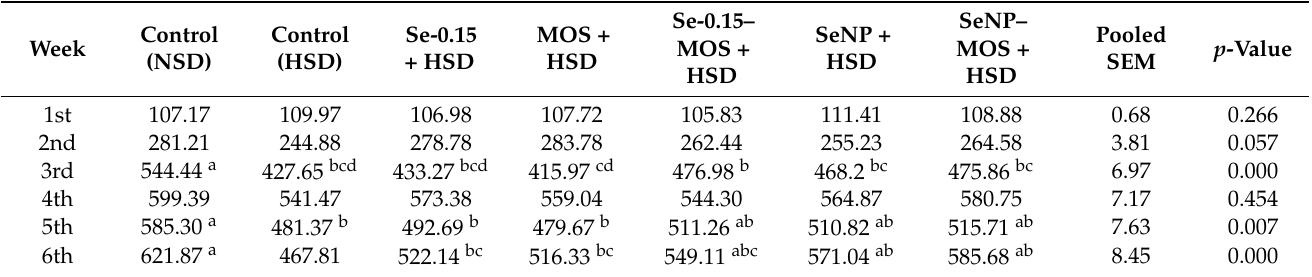
Table 3. Effect of selenium nanoparticles–MOS on body weight gain (grams) of broiler chickens reared under higher stocking